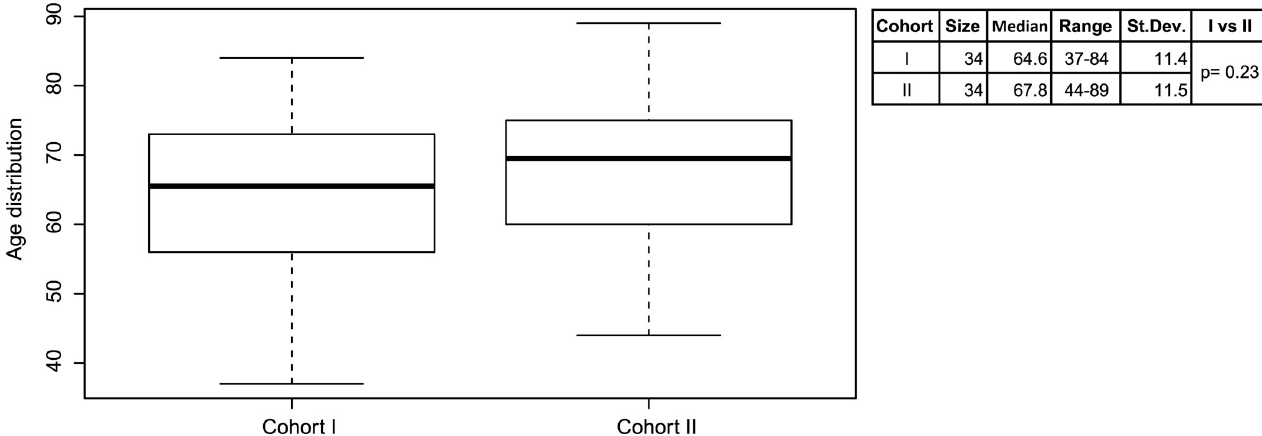
Fig 1. Distribution of age for patients in cohort I (N = 34) and cohort II (N = 34). Median age was 65.5 years for cohort I and 69.5 years for cohort II at the time of routine ctDNA EGFR